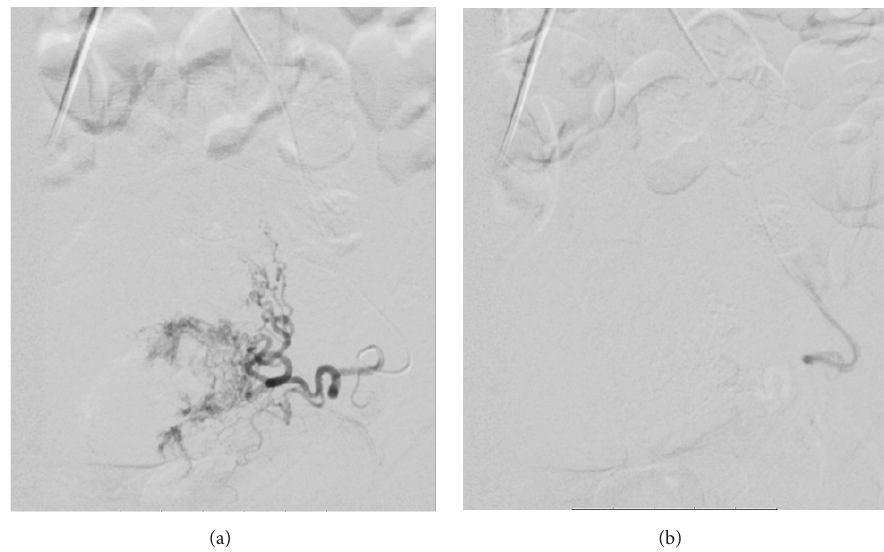
Figure 3: Pre- and postembolization arteriogram showing the bilateral uterine arteries (including the cervical component) prior to embolization with Gelfoam and after ((a) preembolization and (b)